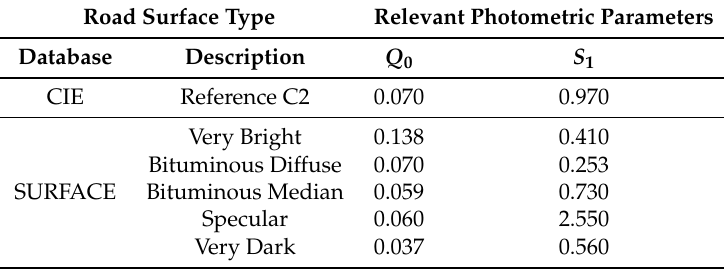
Table 2. Relevant photometric characteristics of selected road